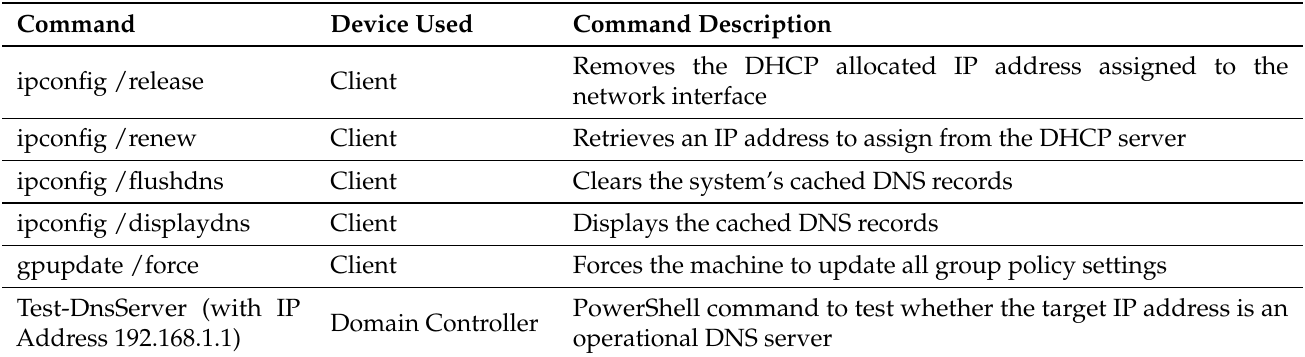
Table 4. Executed commands in the investigation